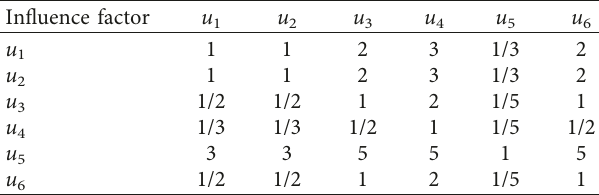
Table 6: Judgment matrix for influence factors in the construction period.